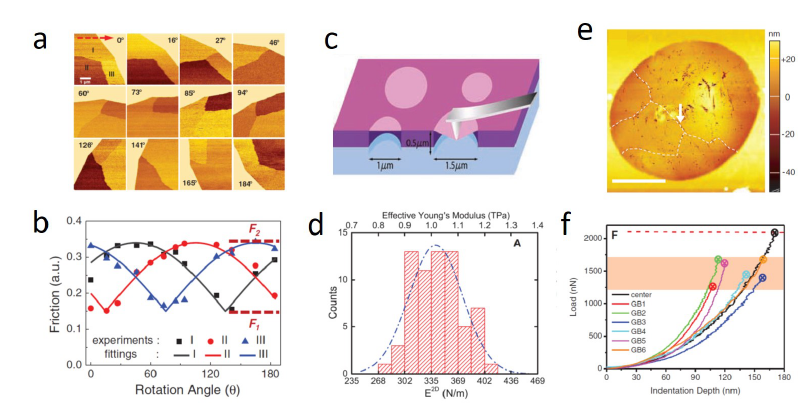
Figure 5. ( a ) Friction force images showing the changing friction contrast of different graphene domains as the sample is rotated from 0 ◦ to 184 ◦ relative to the horizontal scan direction (red arrow); The plot in ( b ) represents the normalized friction force vs. the rotation angle for three different domains, showing a 180 ◦ periodicity (reproduced from [106]); ( c ) Schematic of nanoindentation on a suspended graphene membrane and ( d ) histogram of the elastic modulus measured from force-distance curves on the graphene membrane (adapted from [107]); ( e ) AFM topography of a suspended graphene membrane showing grain boundaries (marked by dashed lines); ( f ) AFM indentation curves showing that fracture occurs at a slightly lower load when AFM tip indents on the grain boundary (reproduced from